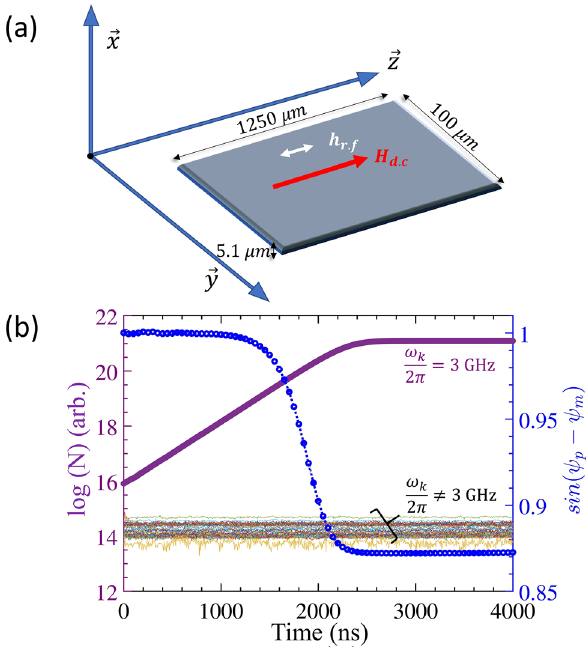
Figure 1. ( a ) Schematic of the sample and pump configuration used in the simulations. The microwave (r.f) signal, h r . f is applied parallel to the magnetic bias field, H d . c . ( b ) Number of magnons, N, resolved in frequency for a pump-frequency of 6 GHz at 2.8 Oe and a bias-field of 200 Oe . ψ p and ψ m are the phases of the microwave pump and the dominant magnon mode, respectively. An exponential rise in numbers occurs only for magnons with frequency, ω k 2 π = 3 GHz i.e., half the pump frequency, while the other magnons with ω k 2 π = 3 GHz remain close to their thermal equilibrium